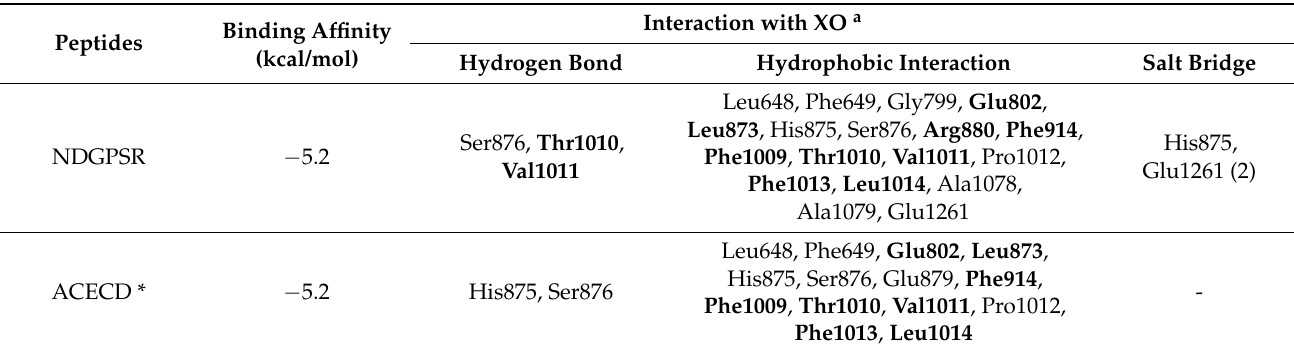
Table 8. Binding affinity and types of interactions between xanthine oxidase (XO) and corn silk peptide NDGPSR, which was predicted to be a non-toxic, non-allergenic, and cell-penetrating peptide, in comparison with a reference peptide.